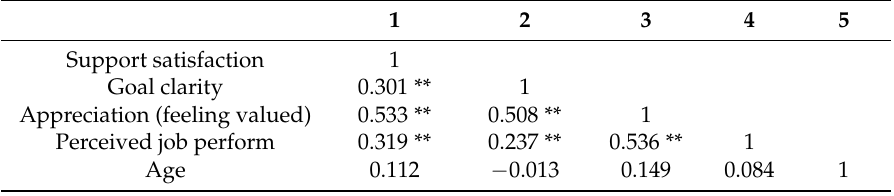
Table 1. Correlations for